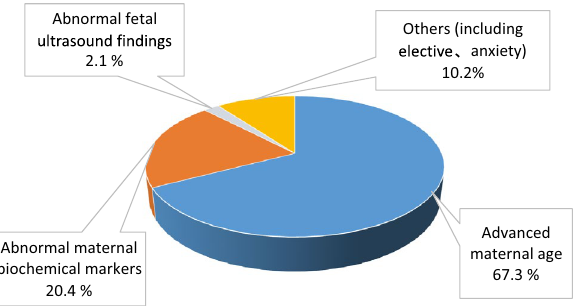
Figure 1. Indications for second trimester amniocentesis in 21,120 patients.